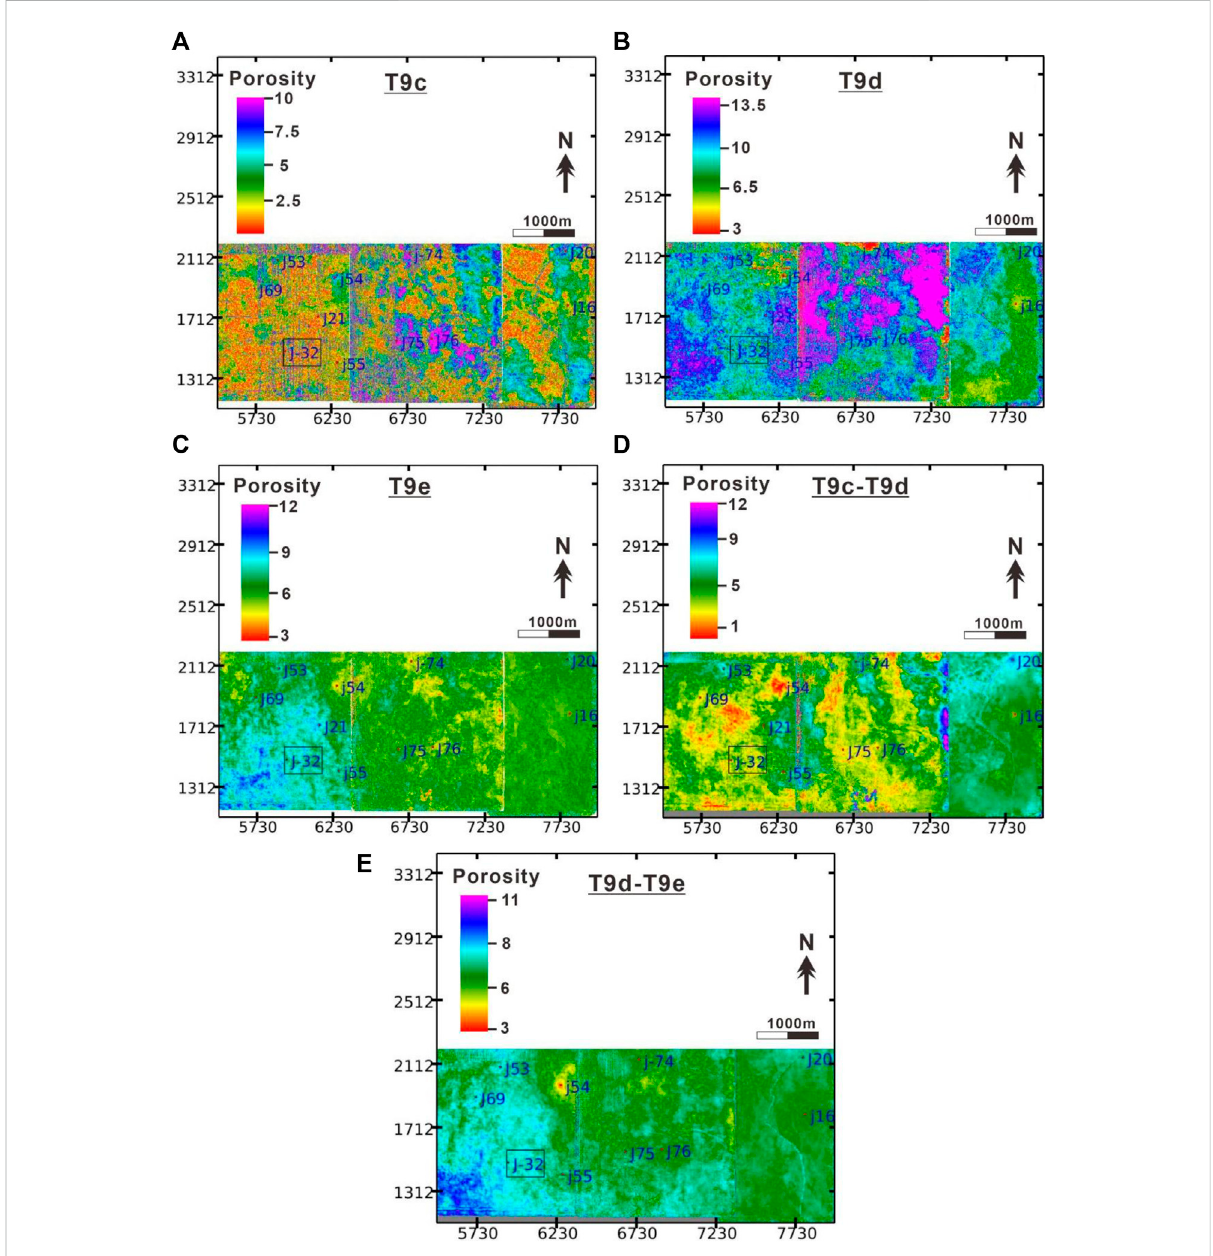
FIGURE 11 Porosity maps of (A) T9c, (B) T9d, (C) T9e, (D) T9c-T9d, and (E) T9d-T9e horizons. The studied well J32 as a case study is highlighted by black color